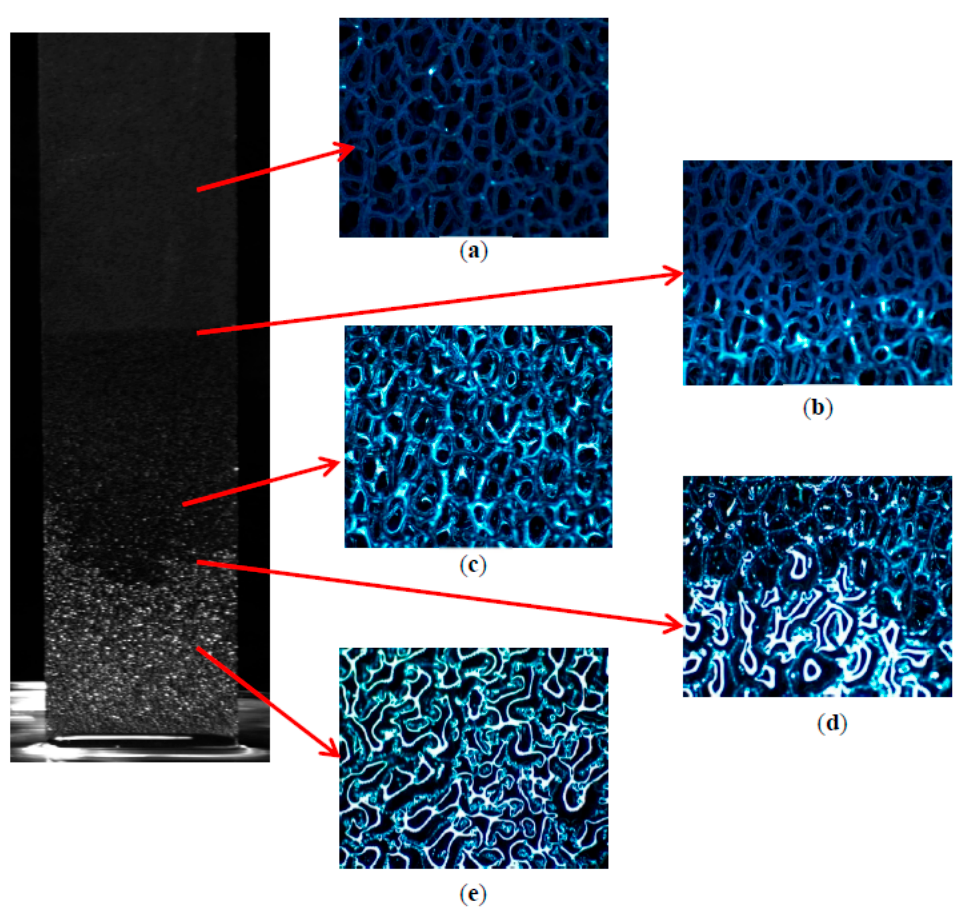
Figure 12. Microscope images of capillary rise process of the copper foam with a thickness of 2.0 mm at 1000 s: ( a ) drying zone; ( b ) upper dividing line; ( c ) unsaturated zone; ( d ) lower dividing line; ( e ) saturated zone.